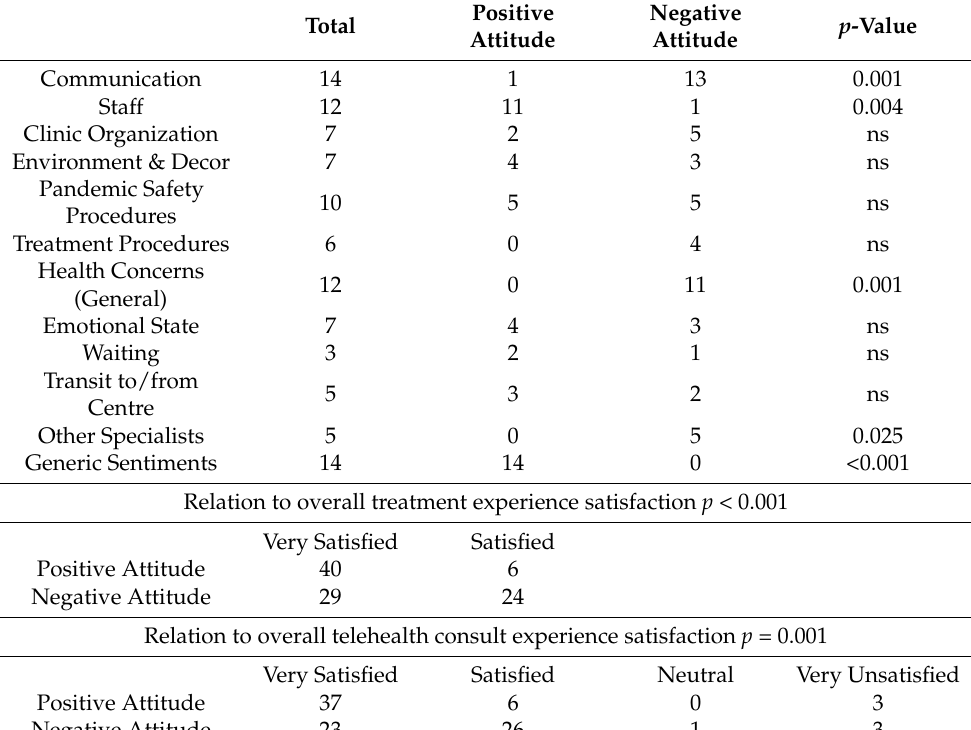
Table 2. Qualitative data from survey responses, codified by commentary topic and attitude. Associ- ations between respondent attitudes to free-text qualitative questions and quantitative experience scores are also